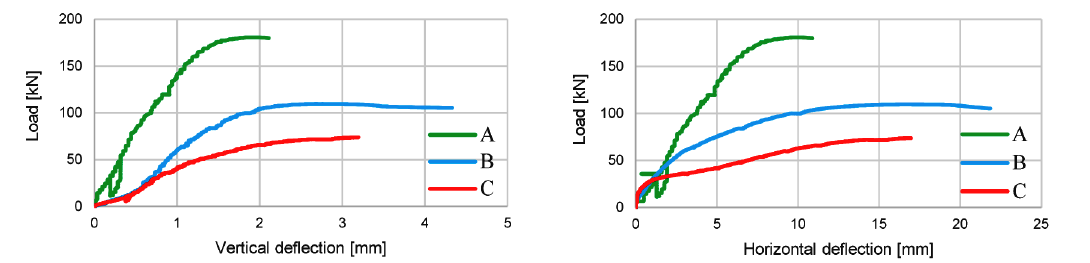
Fig. 3. Load-deflection curve in the vertical and horizontal direction for specimens A, B and C